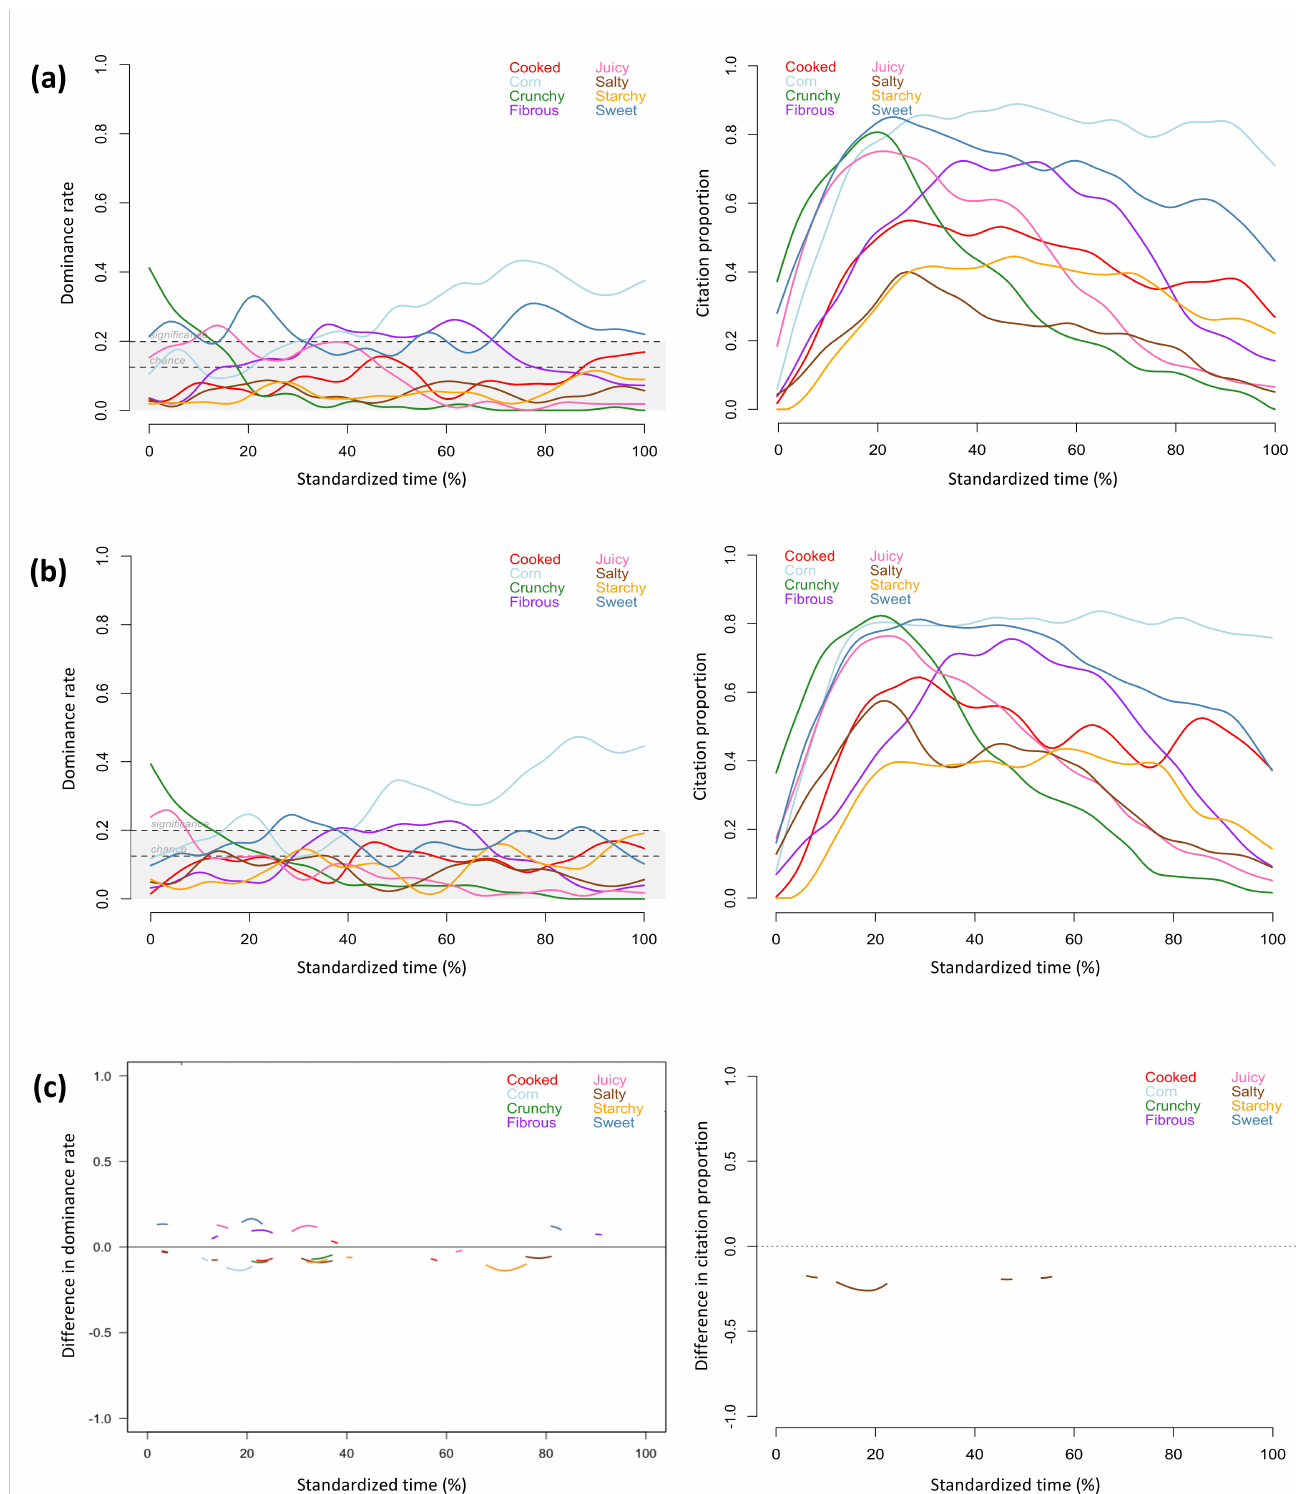
Figure 2. Temporal profiles for regular ( a ) and sodium-reduced ( b ) corn, and significant difference curves ( c ) obtained by TDS (left) and TCATA (right) (n =